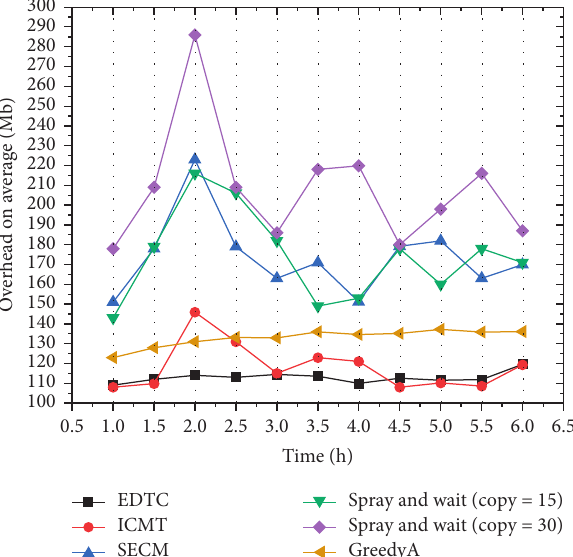
Figure 12: The relationship between delivery ratio and time.